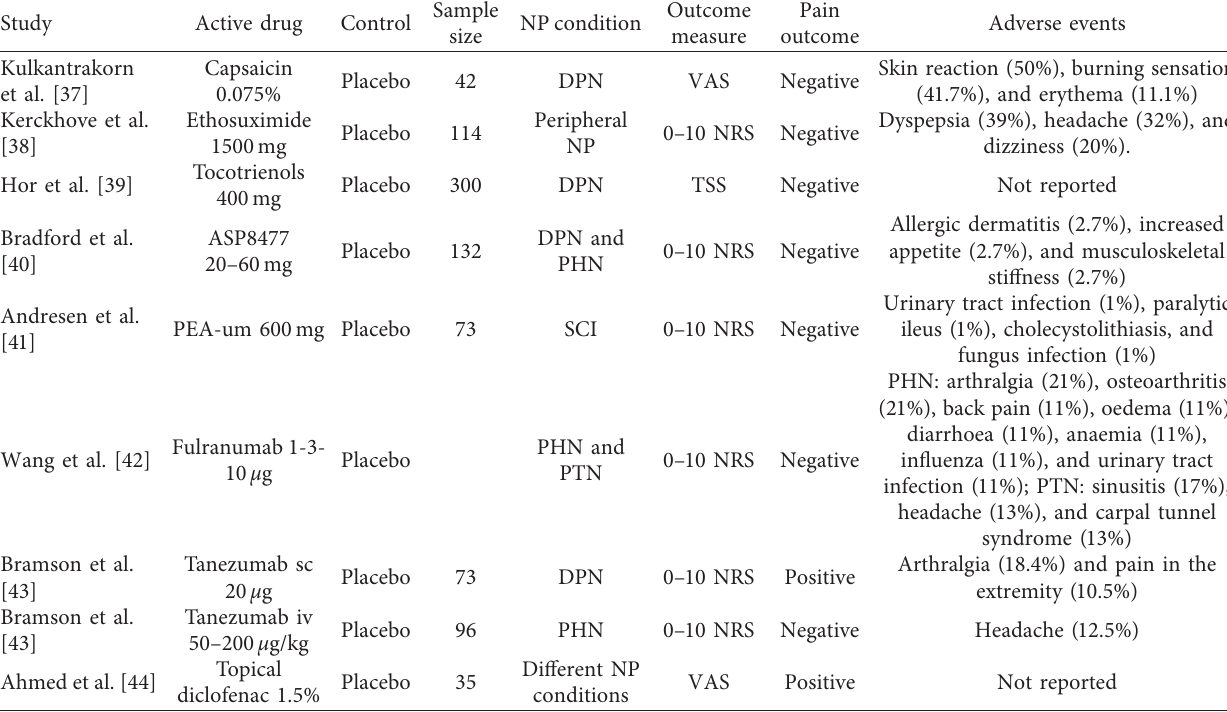
Table 7: Randomized, double-blind, controlled trials testing the effect of other